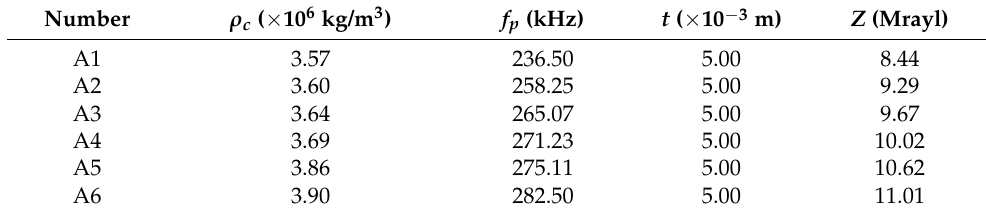
Table 7. Changes in Z of specimens with SL/FA.